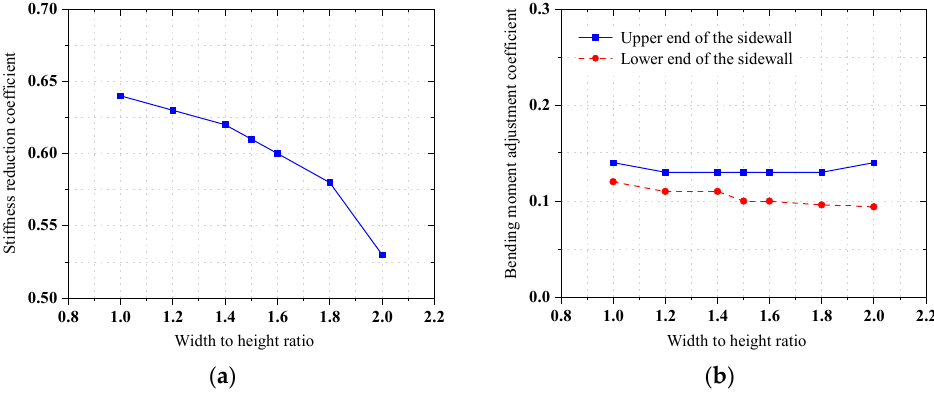
Figure 6. Influence of aspect ratio of width to height: ( a ) stiffness reduction coefficient and ( b ) bending moment adjustment coefficient.